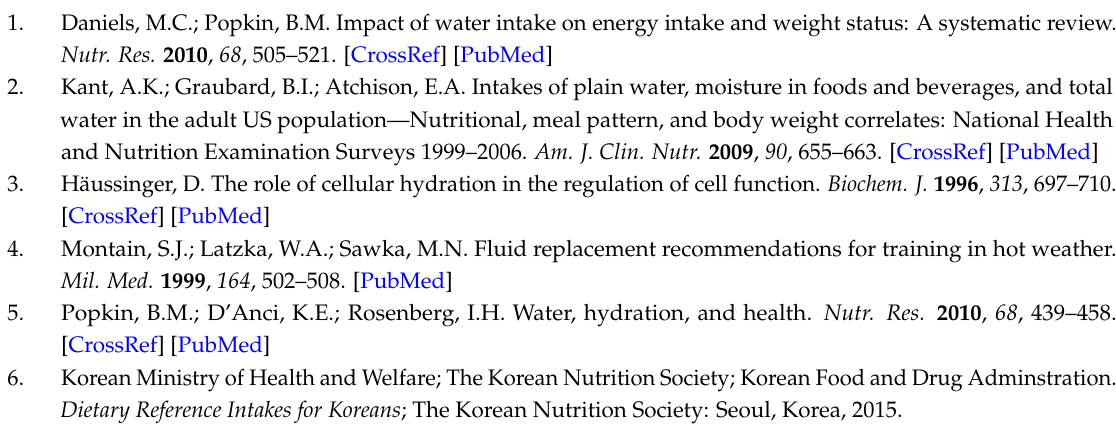
Table S1: Odds ratios and 95% confidence intervals of beverage consumption according to sociodemographic and health-related characteristics in Korean adults, KNHANES 2008–2012 1